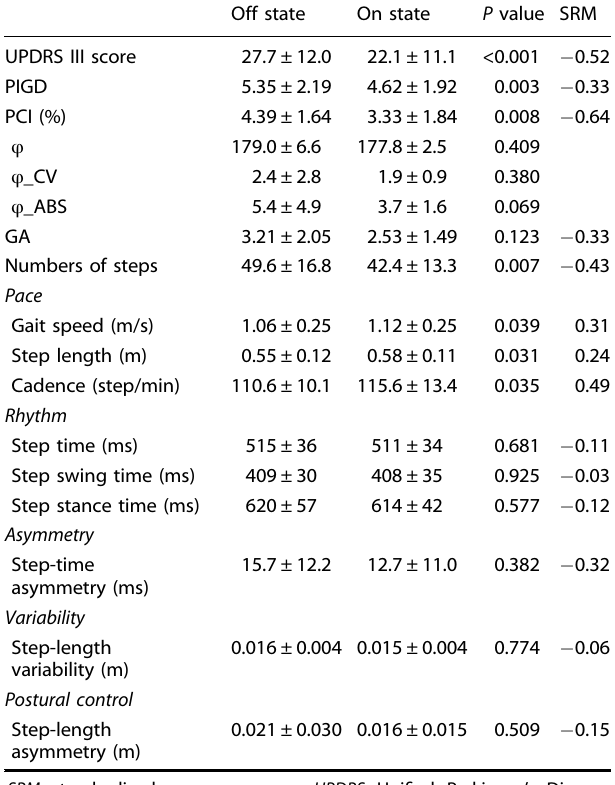
Table 1. Comparison of gait characteristics between “ Off ” and “ On ”